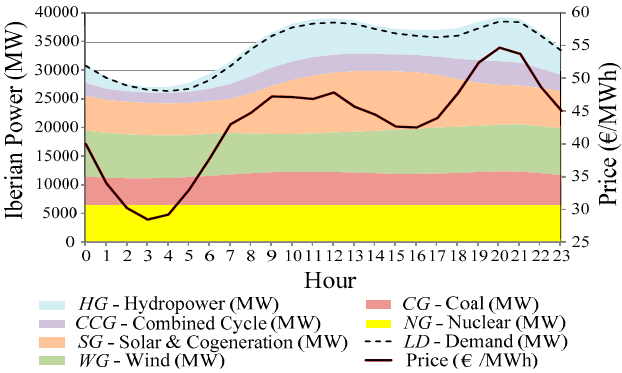
Figure 5. Hourly average power generations, power demand and price in year 2013.